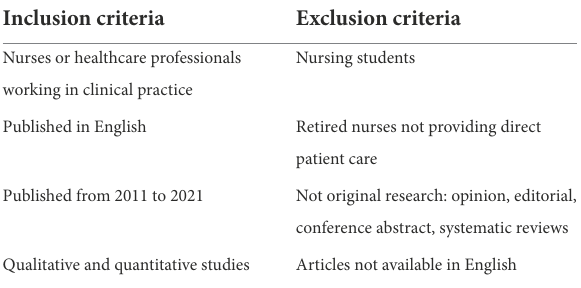
TABLE 1 Inclusion and Exclusion criteria for the scoping